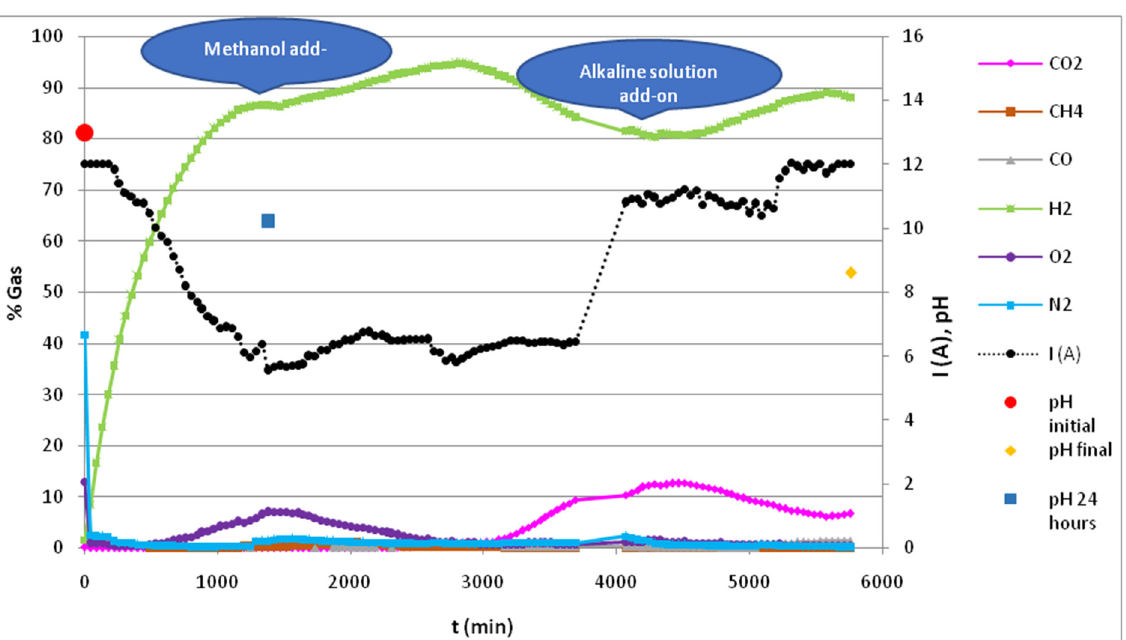
Figure 9. Temporal evolution of generated gases (%) and current in the alkaline (1M KOH) electro- oxidation process of methanol (5M) at a constant electrode voltage of 4.5 V.